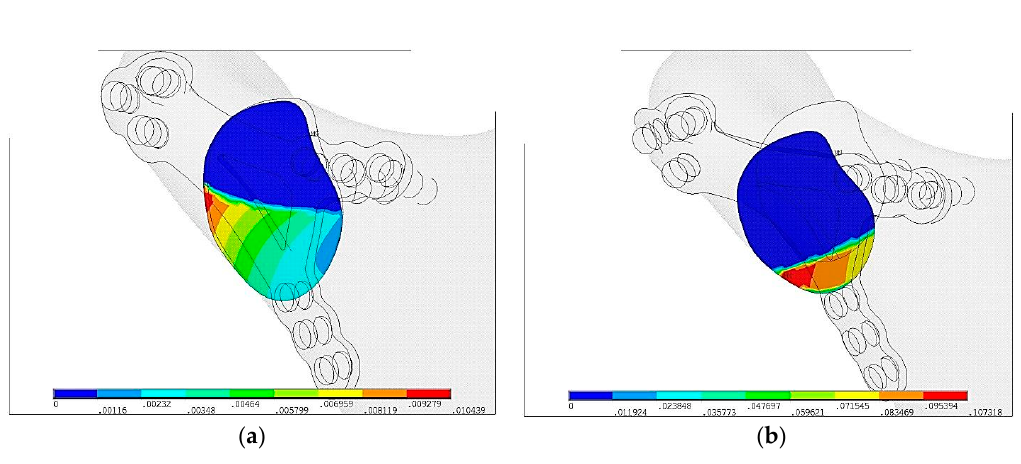
( b ) Figure 7. The size of the fissure between bone ends just after plate fixation in the maximal loading according to the literature [16]: ( a ) Ti-6Al-4V plate fixation, g max = 0.0057 mm, ( b ) PLLA plate fixation, g max = 0.024 mm. Color from blue to red means increasing stresses from 0 to maximum marked on red. In the Figure 8, reduced stresses distribution according to von Mises on PLLA plate with fixing screws made in Ti-6Al-4V and PLLA were the following: σ red max = 234 MPa and σ red max = 76 MPa respectively. Reduced stresses are 4 times lower in PLLA screws than in Ti-6Al-4V grade 5 plate. The fact of paramount importance is that Young modulus for Ti-6Al-4V grade 5 is forty times higher than PLLA. Plate made in more flexible material (PLLA) is prone to higher deformation than Ti-6Al-4V. Titanium alloy grade 5 allow for higher loading forces and make the osseofixation much rigid. Thus titanium alloy material make the healing process easier because of the immobilization of the bone ends. In any of discussed situation, yield stress was not exceeded.